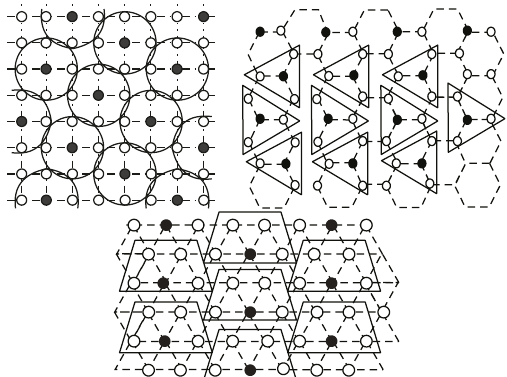
Figure 2: Optimal subnet partitions of large networks on regular topologies for O-SAM: the upper left is square, the upper right is hexagon, and the lower is triangle. The sparseness factor f s is five for the square and triangle topologies and four for the hexagonal topology. The black nodes are concurrent cochannel receivers. One of the blank nodes in each subnet can be a transmitter in that